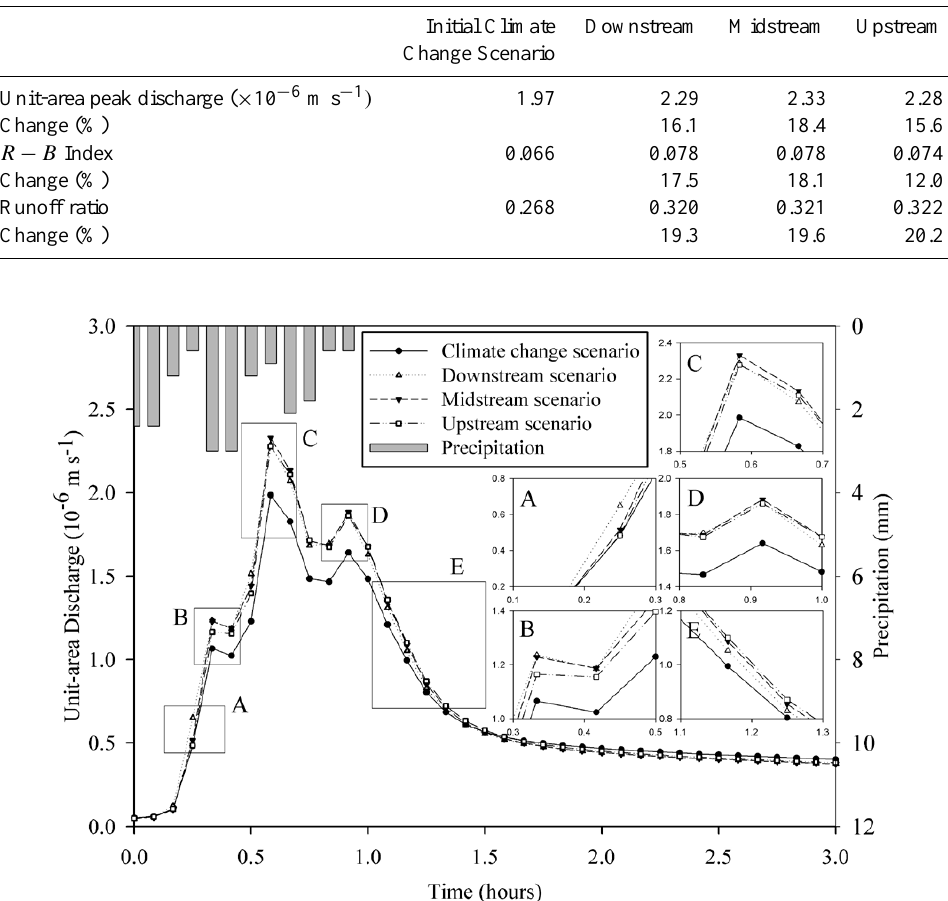
Fig. 5. Precipitation amounts and hydrographs for different distributions of land cover change for WS4. Discharge was standardized by watershed area. Box A illustrates greater discharge for the downstream scenario; Box B and Box D indicate lower peak discharge for the upstream scenario; Box C illustrates greatest peak discharge for the midstream scenario; and Box E indicates greater discharge for the upstream scenario.